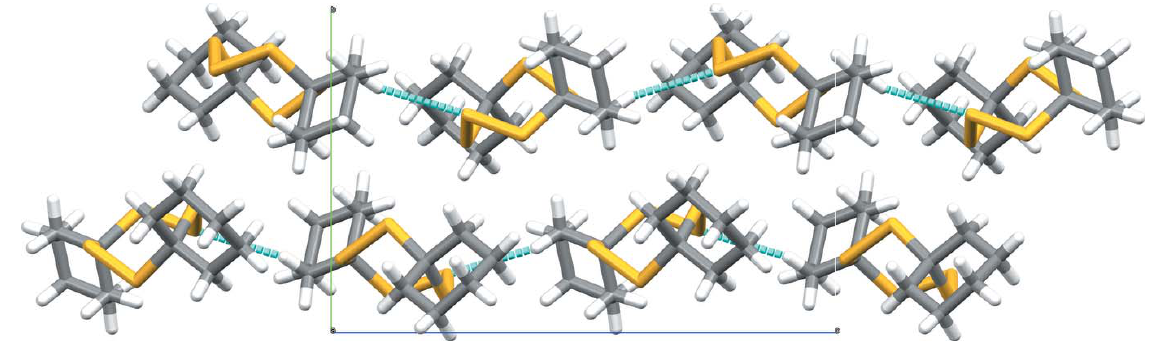
Figure 3 Crystal packing view along the a axis showing the non-classical hydrogen-bonding contacts (blue) protruding along the c- axis direction (analyzed and drawn with Mercury; Macrae et al. ,